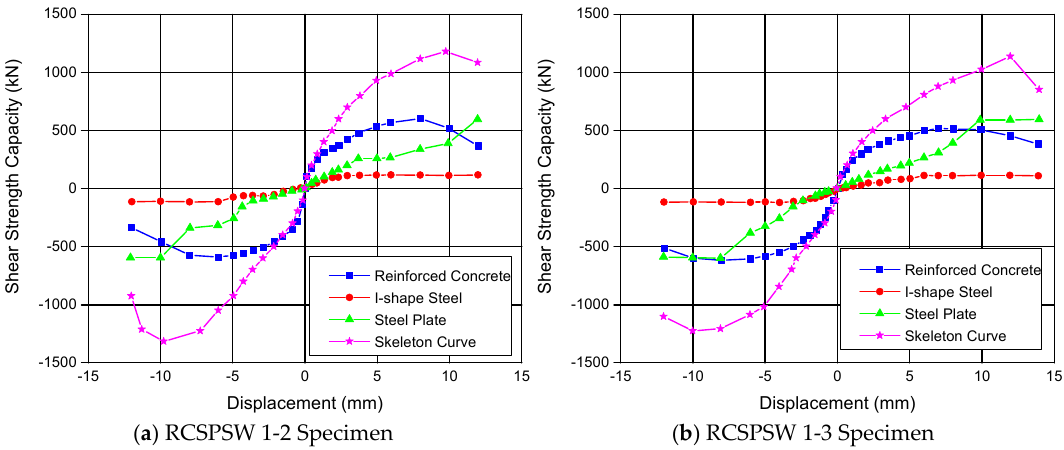
Figure 18. Shear Strength Capacities of RCSPSW Specimens Provided by Different Components.